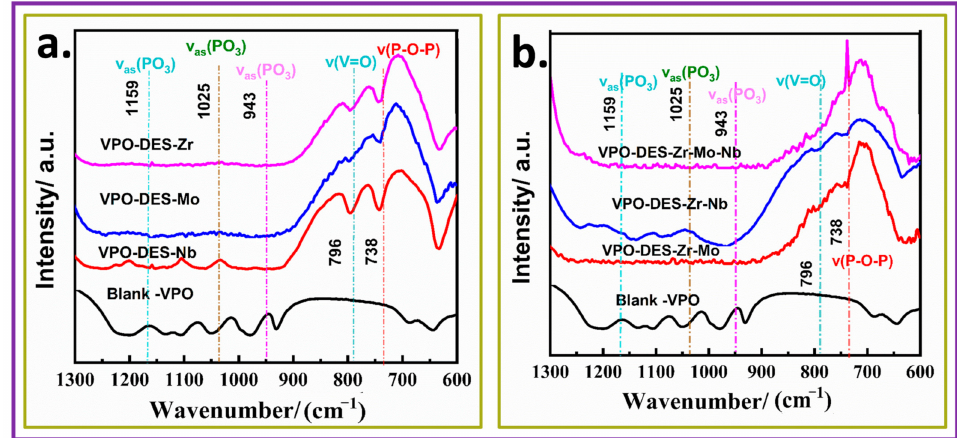
Figure 7. The FT-IR spectra of VPO catalysts prepared from mono- ( a ), and bi- and tri-metallic ( b )